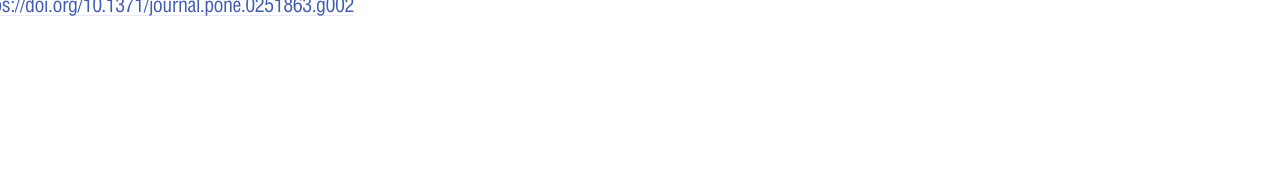
PLOS ONE | https://doi.org/10.1371/journal.pone.0251863 May 17,